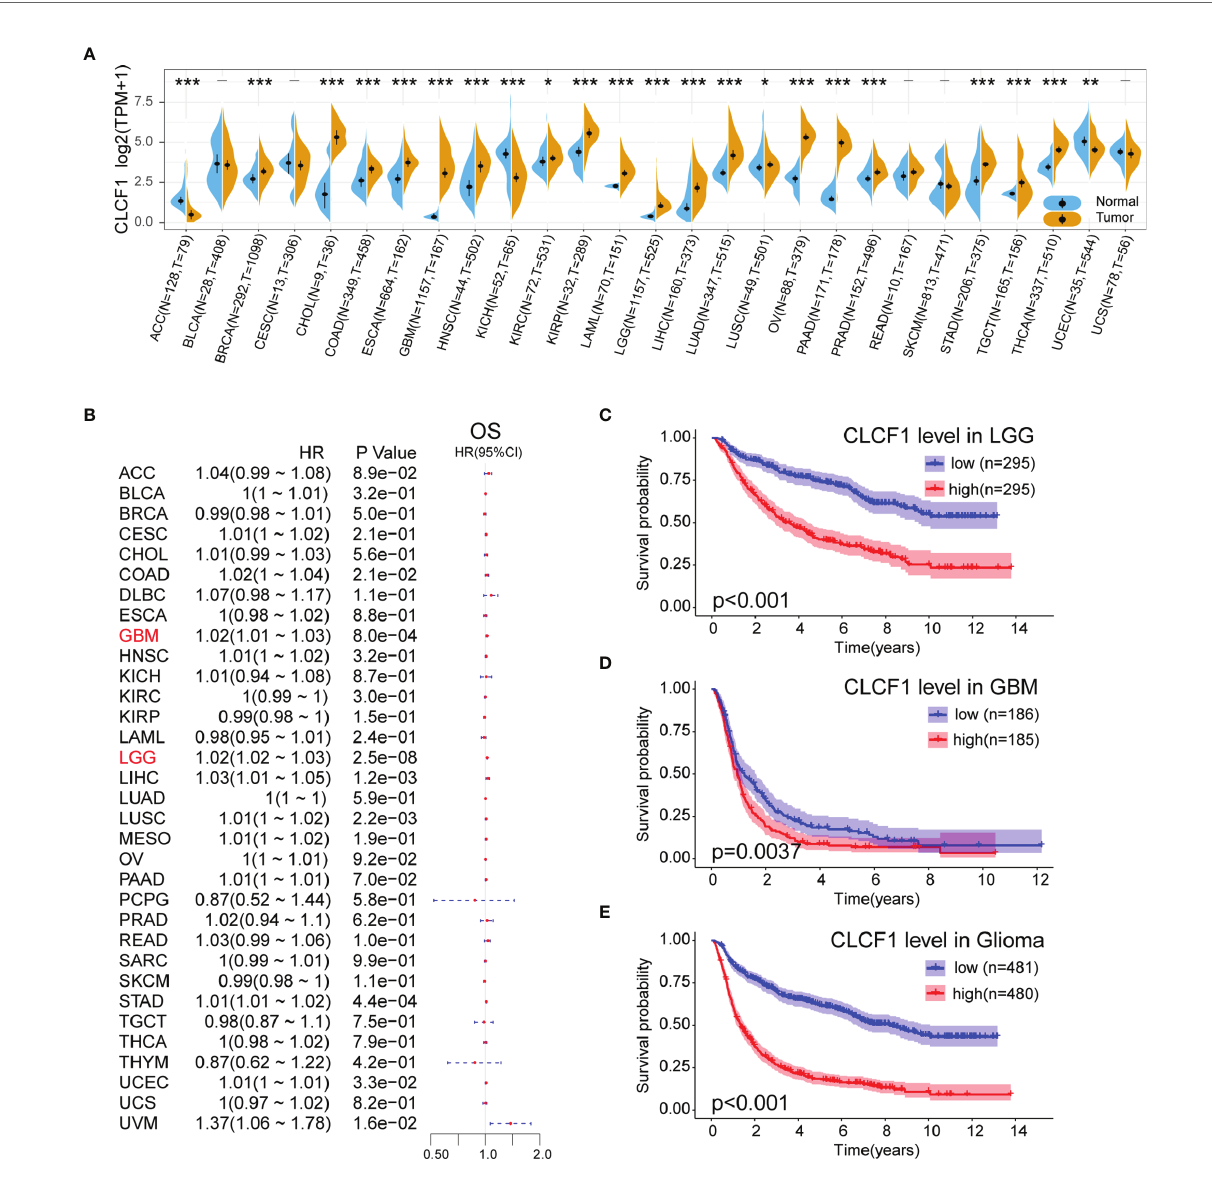
FIGURE 2 | (A) Comparison of CLCF1 expression in different tumor tissues and corresponding normal tissues, Signi fi cance: - P > 0.05, *P < 0.05, **P < 0.01, ***P < 0.001; (B) Univariate Cox Regression analysis of CLCF1 expression and clinicopathological characteristics in different cancers; Kaplan-Meier analysis of CLCF1 in (C) LGG, (D) GBM, and (E) Pan-glioma based on the TCGA